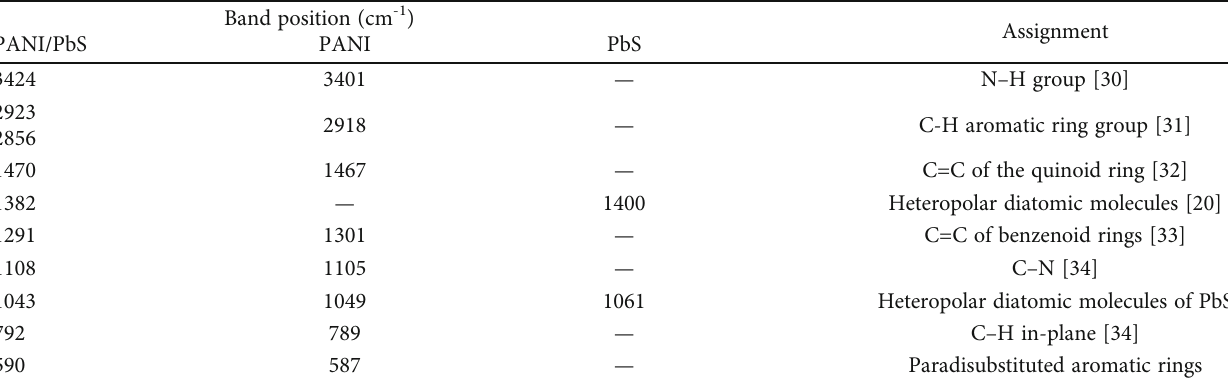
Figure 3: (a) FTIR, (b) XRD, (c) optical absorption, and (d) bandgap of PbS, PANI, and PANI/PbS nanomaterials. Table 1: The FTIR data of PbS, PANI, and PANI/PbS